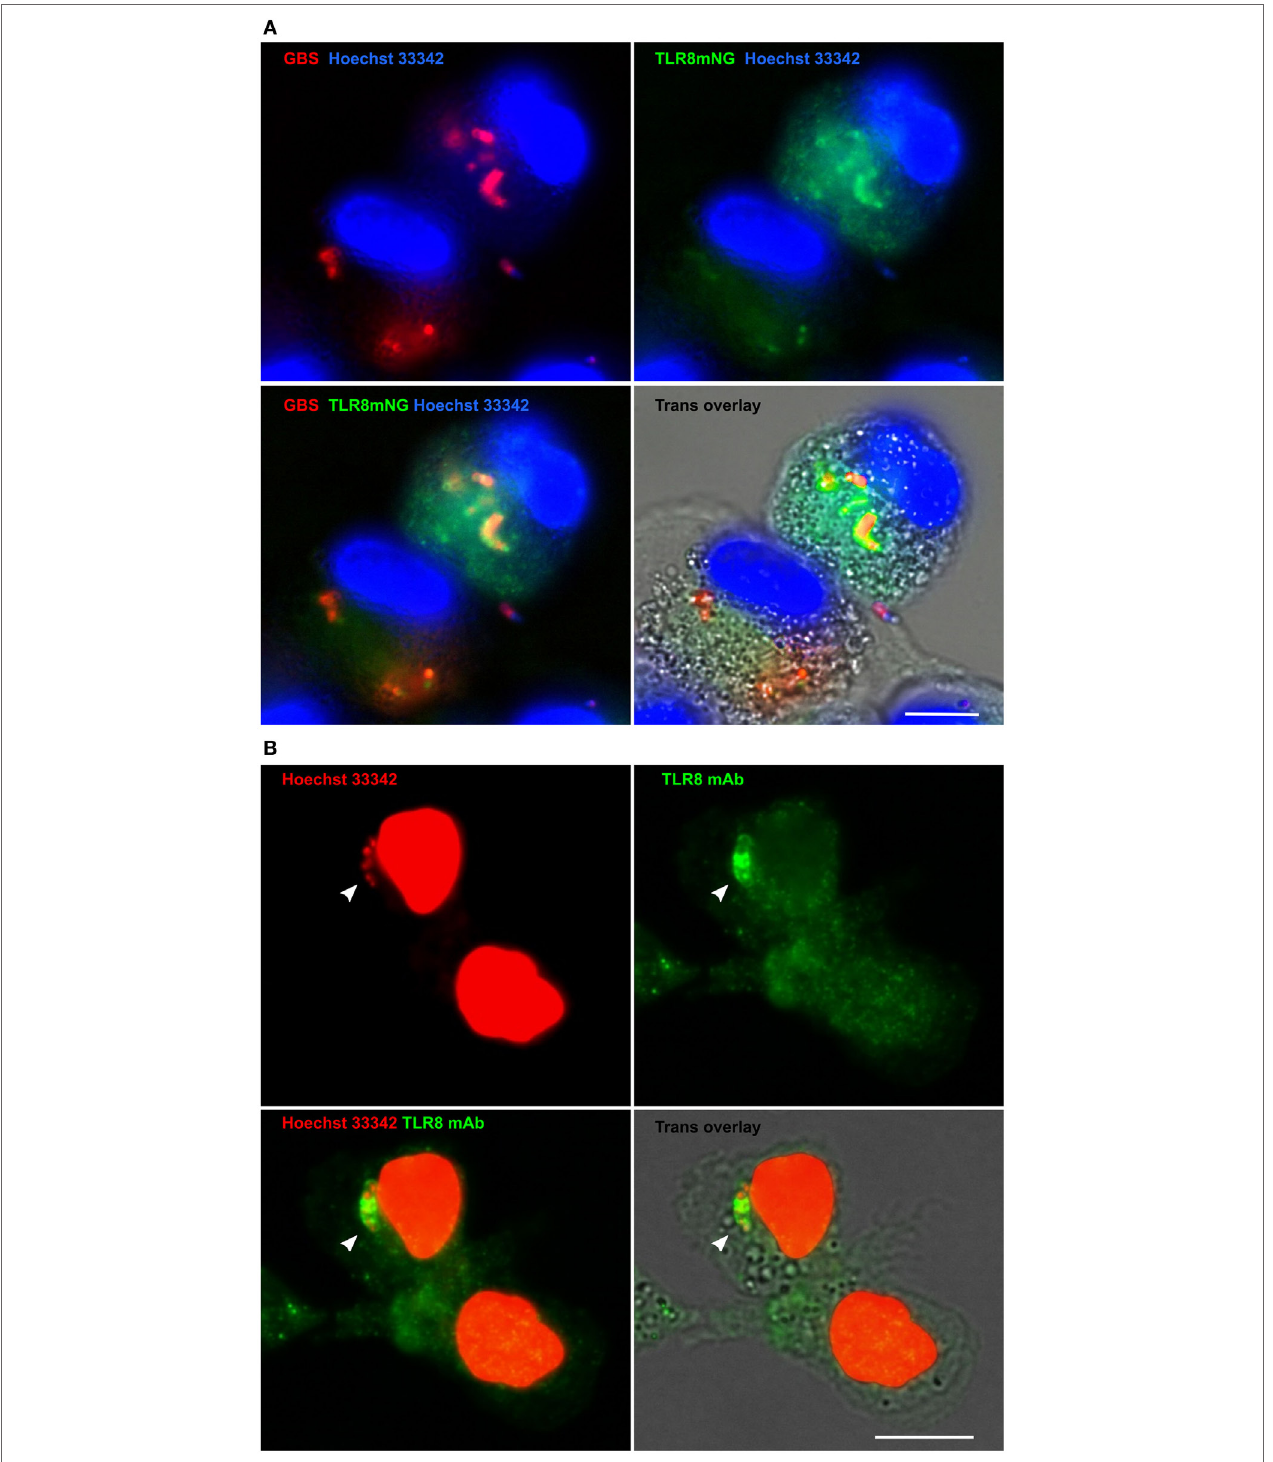
FigUre 6 | TLR8 accumulates on Group B Streptococcus (GBS) phagosomes in macrophages and monocytes. (a) THP-1 TLR8-KO cells were transduced with TLR8 mNeonGreen construct (TLR8mNG) and differentiated with PMA. Macrophages were infected with viable GBS (MOI 1.0) prestained with Alexa 647. Gentamycin was added 1 h postinfection and cells were fixed with paraformaldehyde after 20 h. DNA was stained with Hoechst 33342. (B) Primary monocytes were infected with viable GBS (MOI 10), and Gentamycin was added 1 h postinfection. Cells were fixed with paraformaldehyde after 3 h and TLR8 was IF stained with a mAb. DNA was stained with Hoechst 33342 in PBS/saponin to visualize GBS phagosomes (arrowhead) and monocyte nuclei. Images were acquired using Olympus Scan^R (60 × ). Scale bars are 10